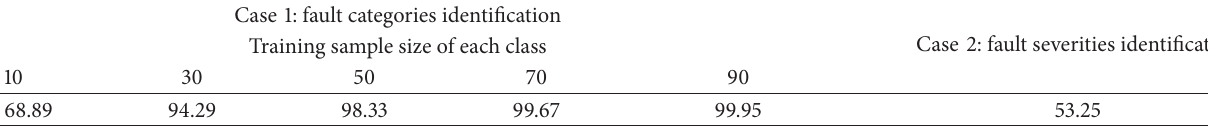
Table 5: The average recognition rates (%) of the simple features based on